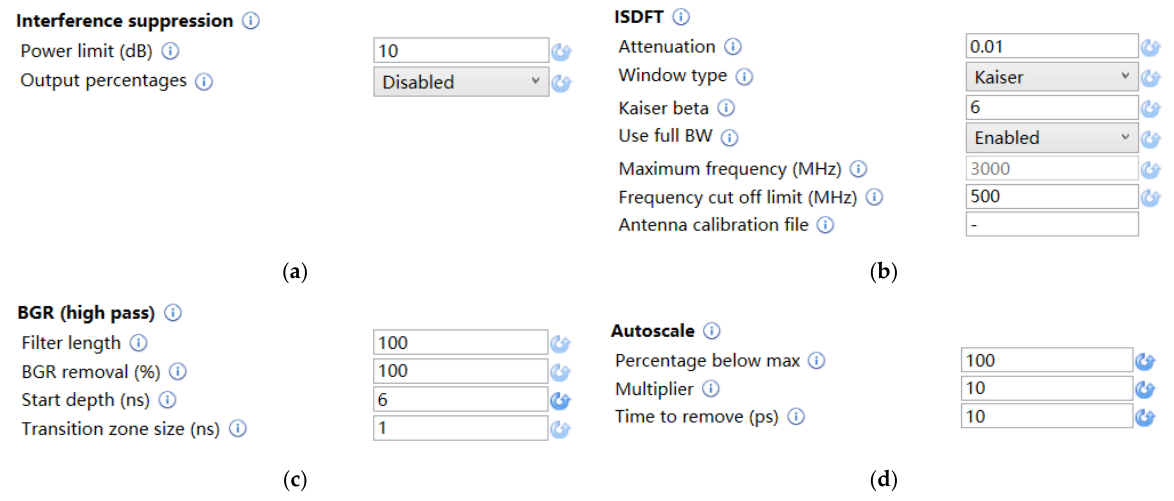
Figure 4. The parameter settings of preprocessing. ( a ) Interference suppression. ( b ) ISDFT (Inverse Fourier Transform). ( c ) BGR (high pass). ( d ) Autoscale.